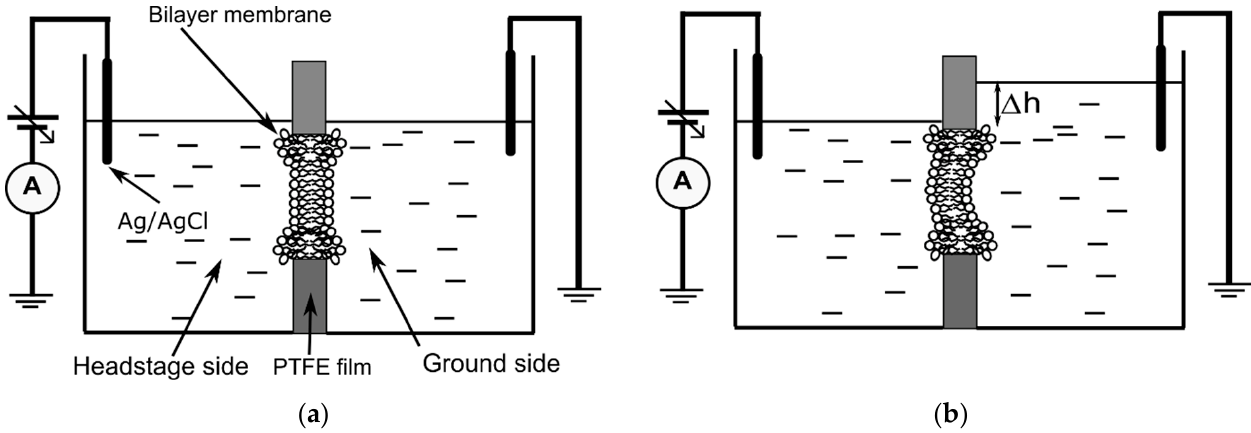
Figure 1. The experimental setup for investigations on ionic transport through lipid membranes exposed to controlled differential pressure. Left ( a ): a planar bilayer lipid membrane is formed in a traditional setup. Right ( b ): the planar membrane is subjected to the pressure created in one reservoir through addition of electrolyte solution. The physical and transport properties of the membranes are monitored by electrophysiology measurements (capacitance and conductance). For both schematics, the Plateau-Gibbs border (annulus) is observed at the lipid membrane-PTFE film interface. The diagrams are not to scale.